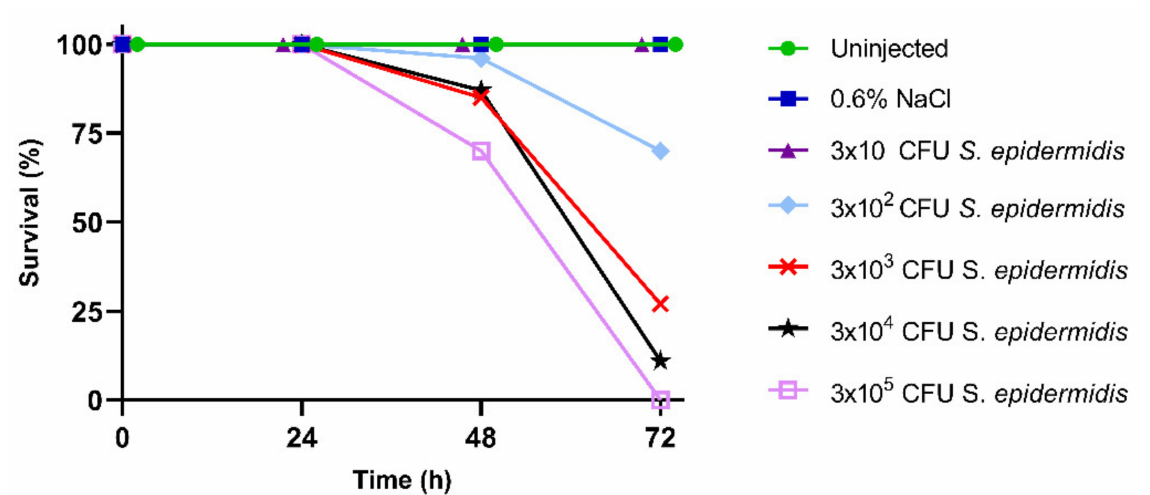
Figure 1. Survival rate of B. mori larvae injected with increasing CFU (colony forming unit) of S. epidermidis .